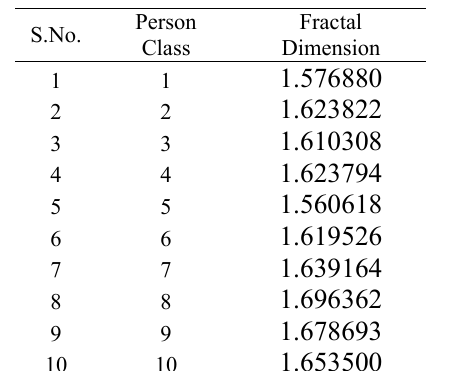
Fig. 3. SSM with 16 x 16 locations of a sample face imageof the first person in AT & T face database.